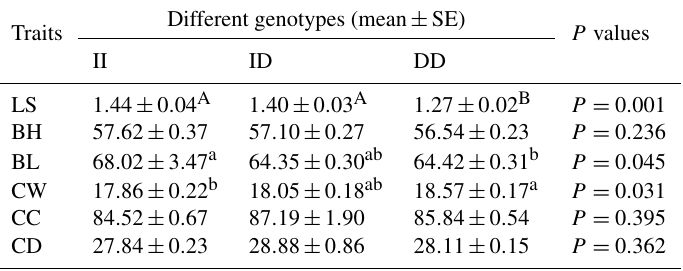
Table 4. The relationship between three genotypes of the PITX2 indel variants and traits in Shaanbei white cashmere (SBWC) goats.